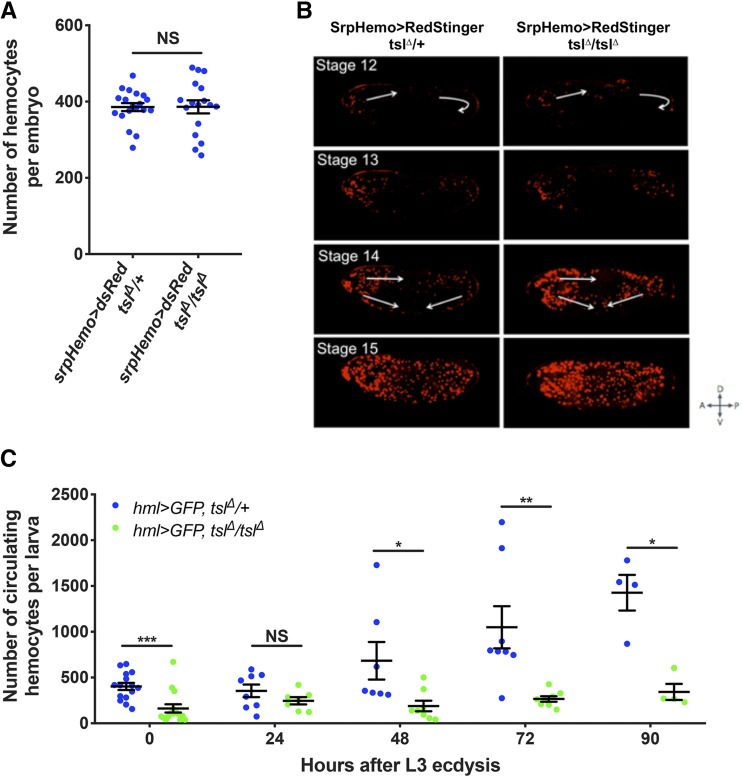
Tsl influences larval hemocyte numbers. (A) Hemocyte numbers in stage 16 tslΔ/ tslΔ and tslΔ/+ embryos (srpHemo-GAL4 > UAS-RedStinger). No difference in hemocyte number was observed. (P = 0.821, n ≥ 17). (B) Stills from live-imaging of stage 12-15 tslΔ/ tslΔ and tslΔ/+ embryos. Arrows indicate the movement of hemocytes. No difference in migration pattern was observed between tslΔ/ tslΔ and tslΔ/+ control embryos. (C) Circulating hemocyte counts from tslΔ/tslΔ and tslΔ/+ larvae at regular time points after transitioning to the third larval stage (L3) of development (n ≥ 4). NS, not significant, *P < 0.05, **P < 0.01, ***P < 0.001, Mann-Whitney test. Data points are individual animals with means ± 1 SE indicated.